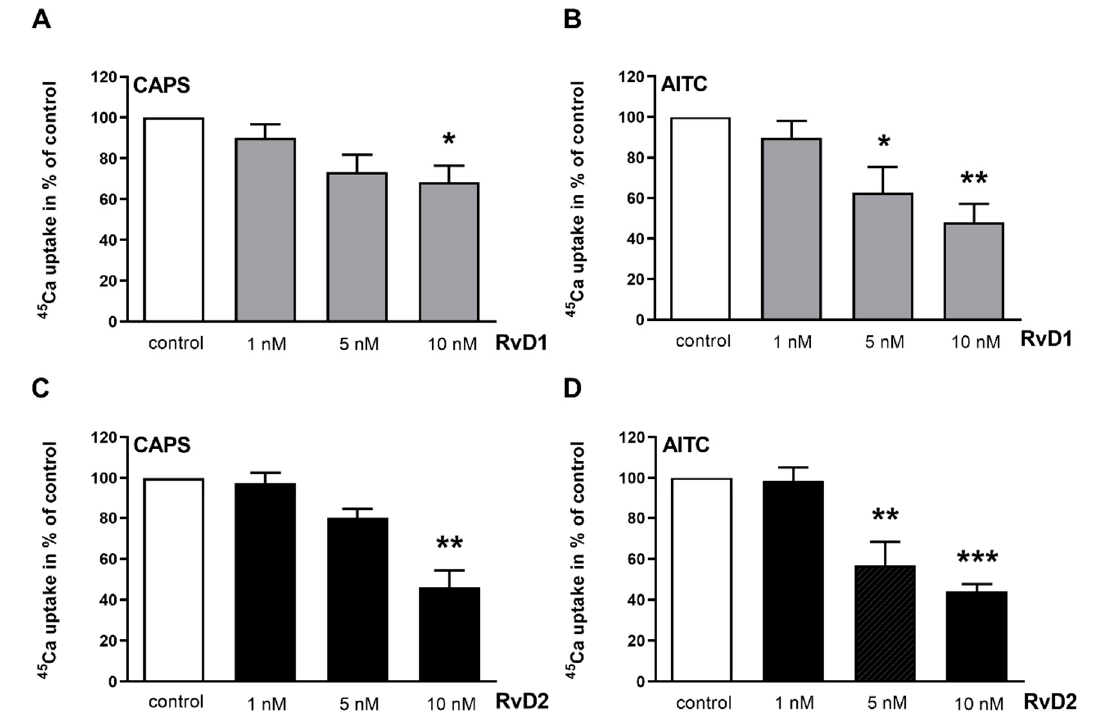
Figure 6. E ff ect of RvD1 and RvD2 on CAPS- and AITC-evoked 45 Ca-uptake on CHO cells expressing the cloned TRPV1 and TRPA1 receptor. ( A , B ): E ff ect of RvD1 on TRPV1-expressing ( A ) and TRPA1-expressing ( B ) CHO cells in radioactive 45 Ca-uptake experiments after CAPS (100 nM)